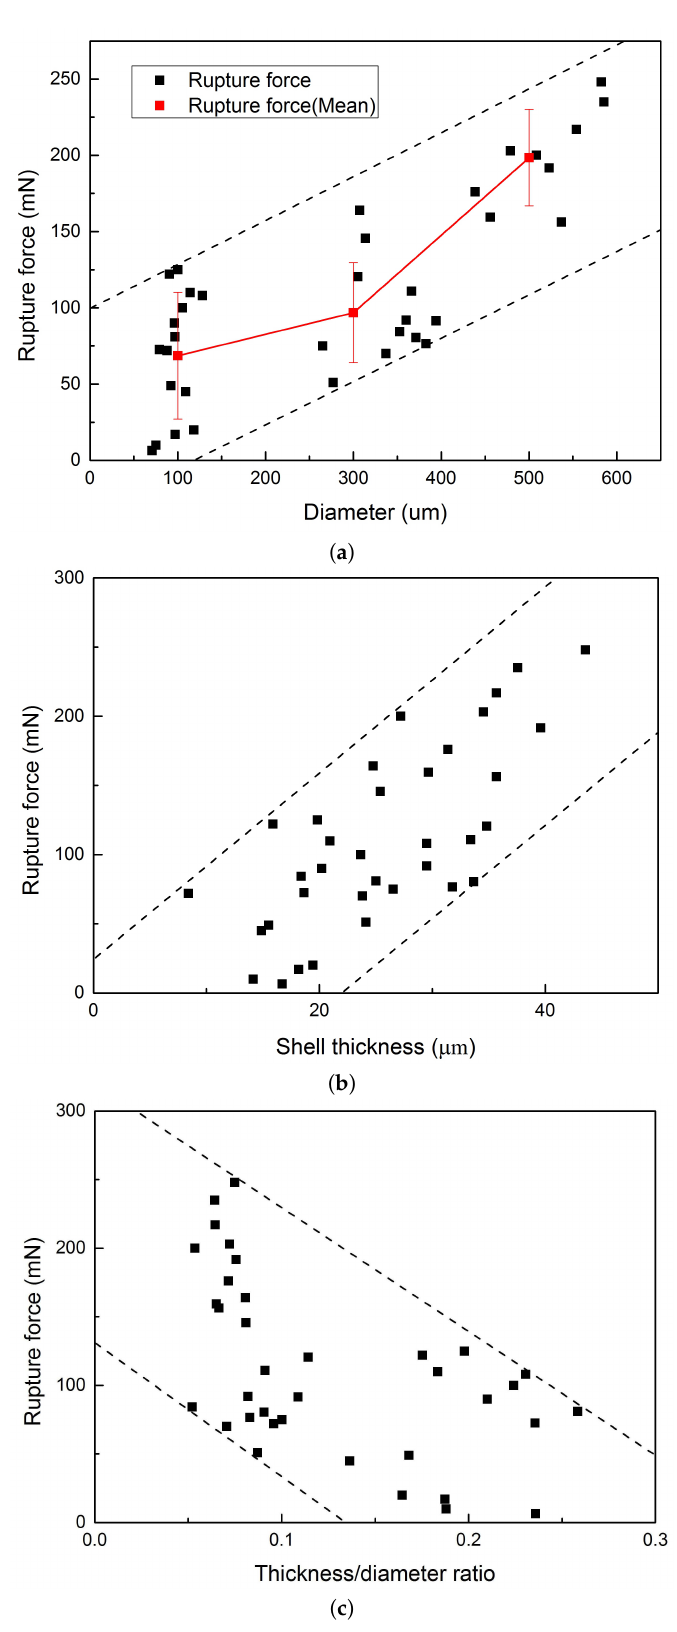
Figure 11. The relationship between the rupture force of PF microcapsules and their ( a ) diameter; ( b ) shell thickness; and ( c ) thickness/diameter